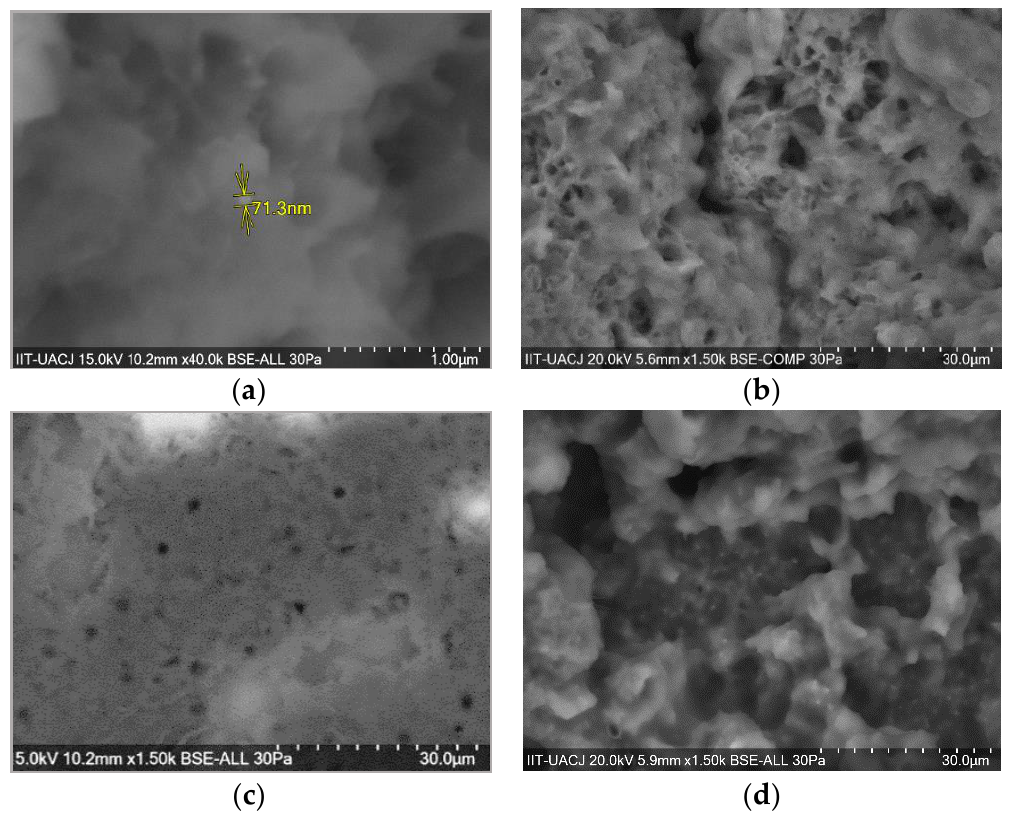
Figure 18. SEM images of ( a ) P2 (20%) at 40,000 × , ( b ) P2 (20%) at 1500 × , ( c ) P3 (30%) at 1500 × and ( d ) P4 (40%) at 1500 × .